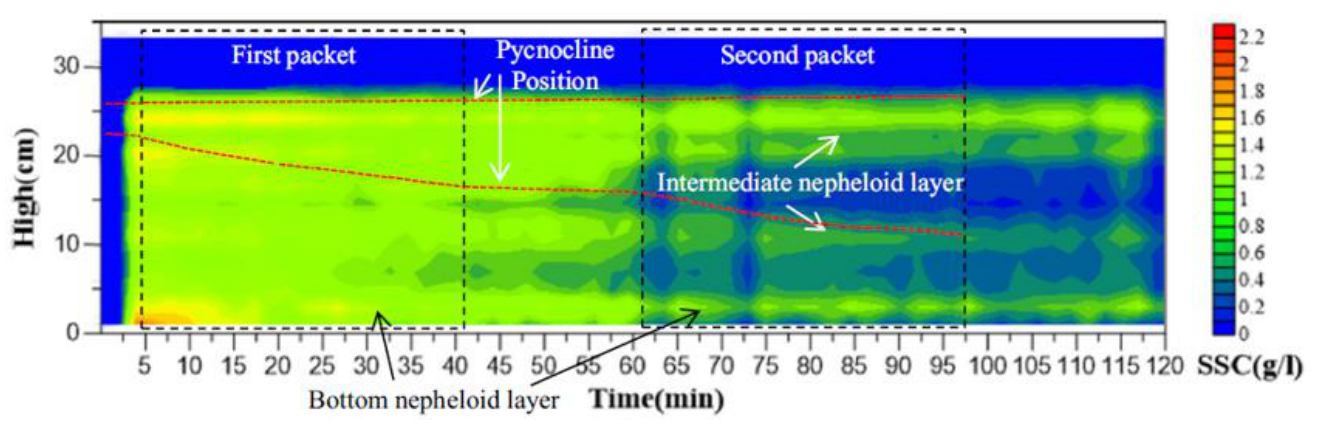
Figure 9. Time series of the suspended sediment concentration (SSC) profile of clayey silt beneath the high-frequency internal solitary wave packet [83]. The black dashed square indicated the time with internal solitary wave packets. The red dashed line above indicated the initial pycnocline position and the line below indicated the real pycnocline position.